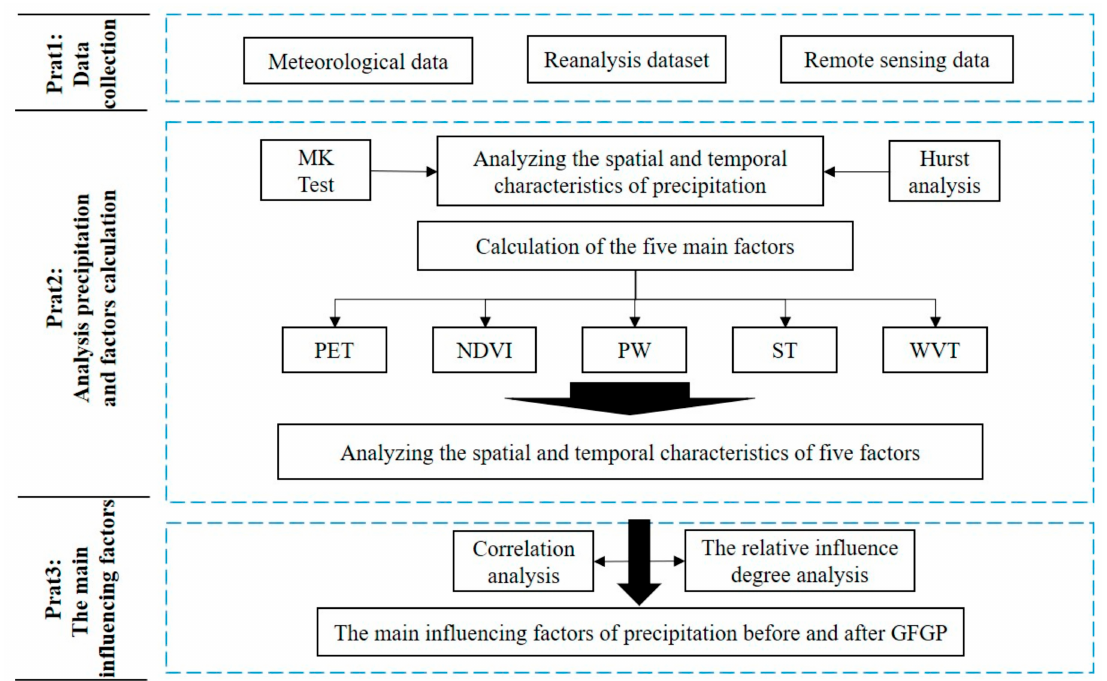
Figure 2. Technical roadmap of this